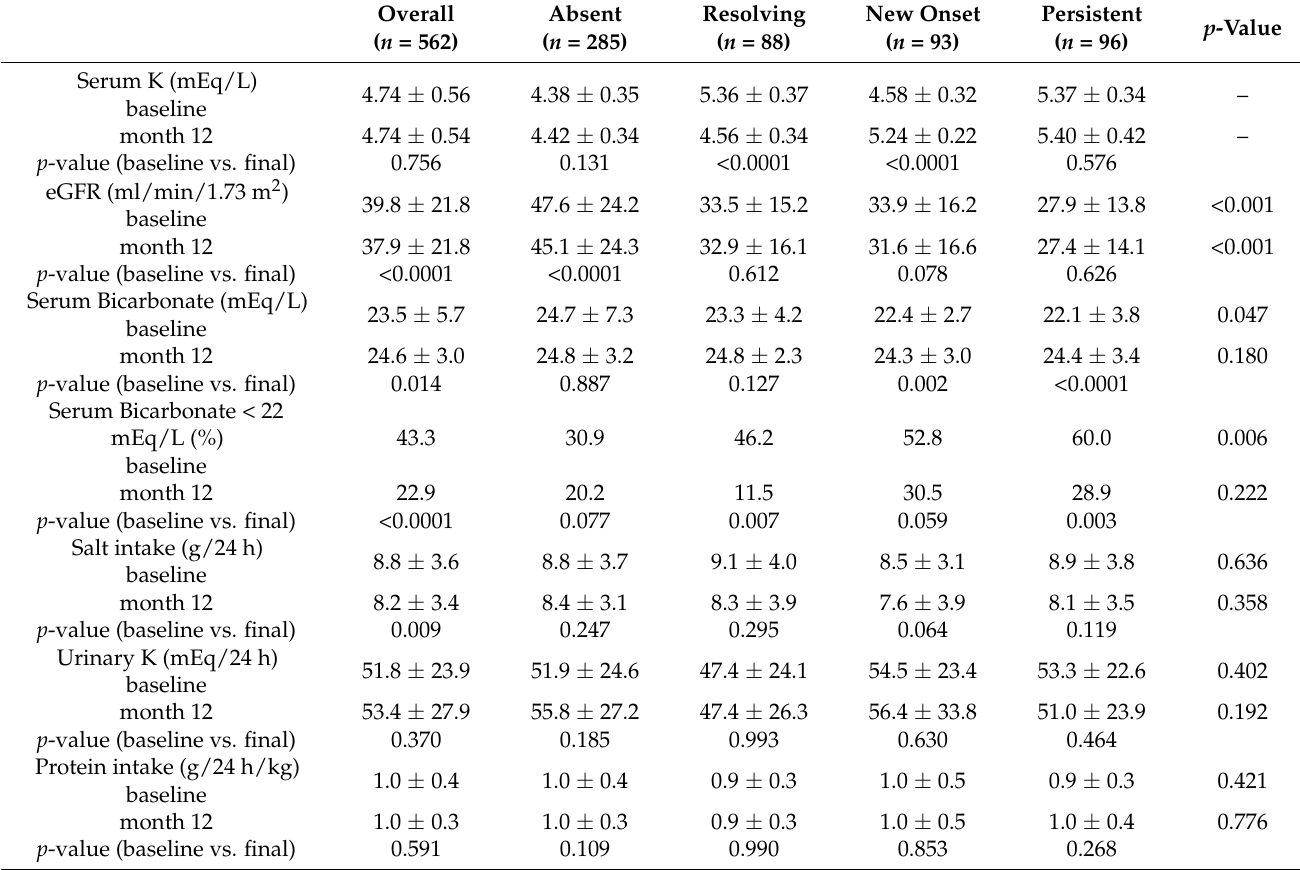
Table 2. Main laboratory parameters at baseline and month-12 visit in the whole cohort and HK subgroups. Overall ( n = 562)